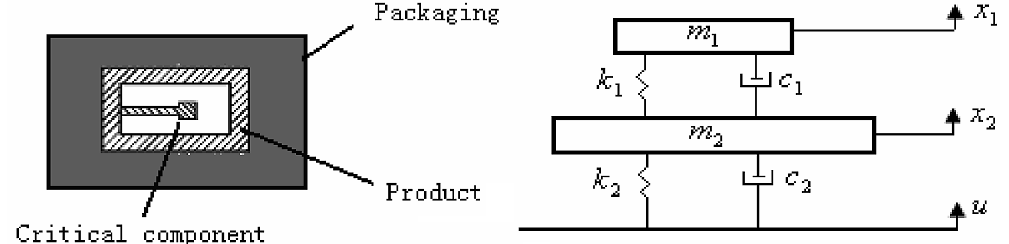
Fig. 1. Model of packaging system with critical